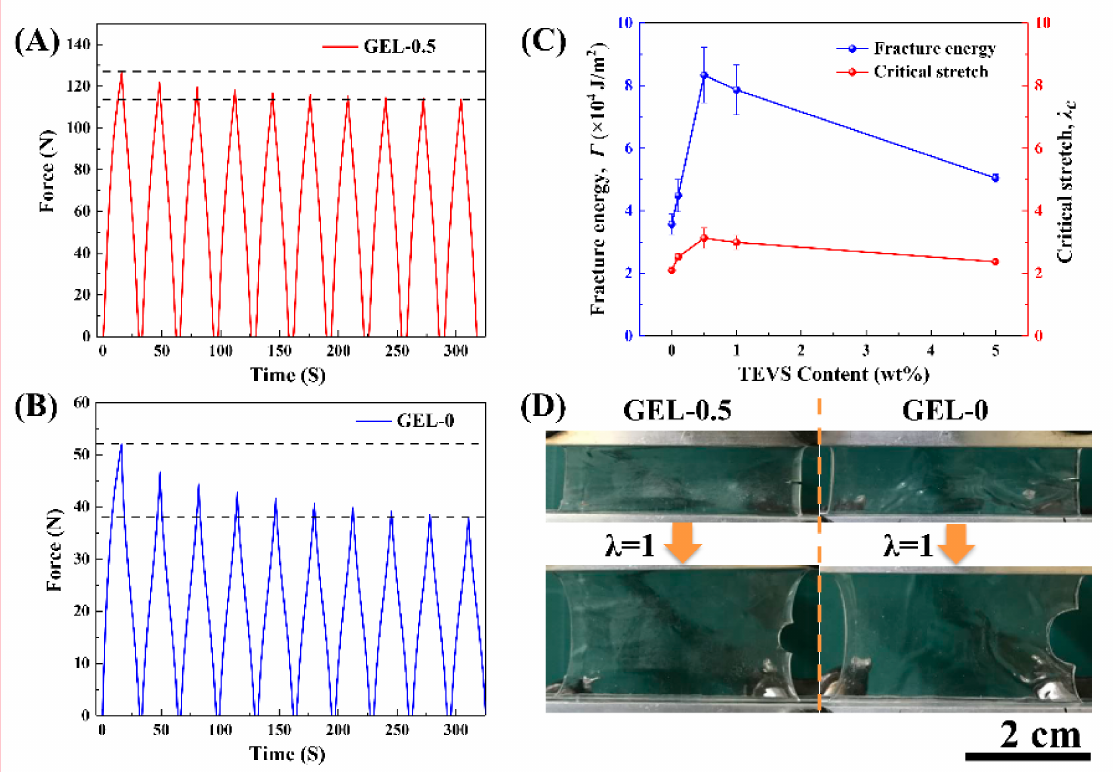
Figure 9. ( A ) Cyclic tensile curves for 10 cycles of GEL-0.5 with single-notch (4 mm) at a strain of 100%; ( B ) cyclic tensile curves for 10 cycles of GEL-0 with a single-notch (4 mm) at a strain of 100%; ( C ) the